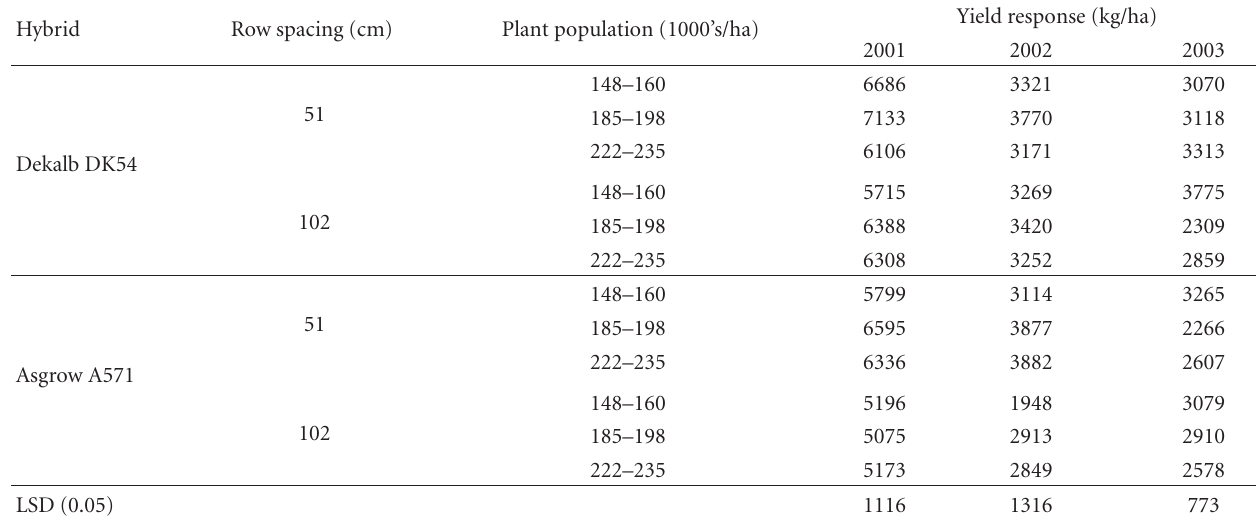
Table 2: Grain sorghum yield as influenced by hybrid, row spacing, and seeding rate. Hybrid Row spacing (cm) Plant population (1000’s/ha)